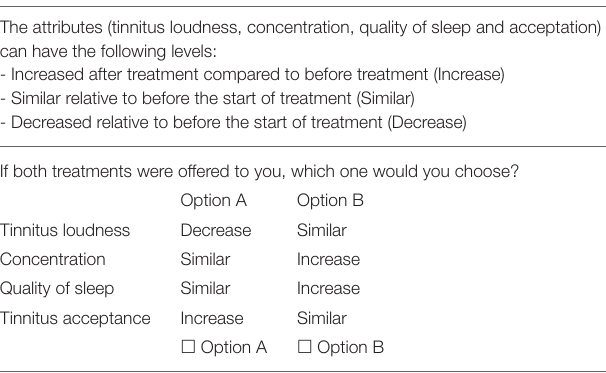
TABLE 1 | Example of a choice